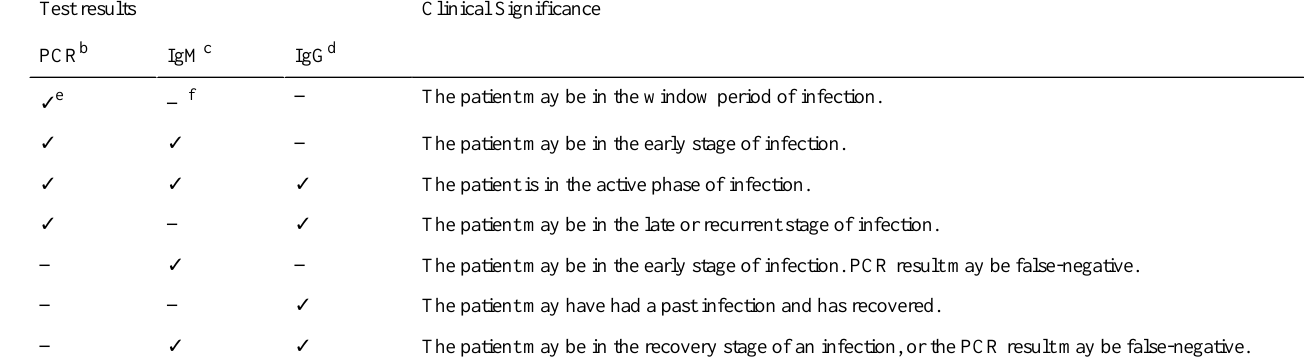
Table 1. How to interpret the results of PCR and antibody results. a